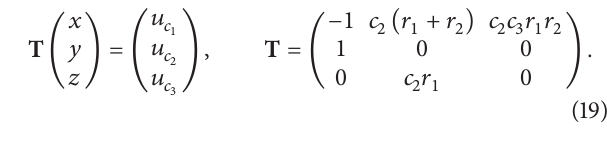
Figure 12: Monte Carlo analysis (for case 𝐴 ) for various standard deviations (Gaussian distributed) around nominal values (2) for resistors 𝜎 𝜎 𝑅 and capacitors 𝐶 . Graphs can be understood as histograms in %, where the sum of values in histogram represents denotes fixed point solution, pink color is a limit cycle, yellow is chaotic motion, and brown color marks unbounded